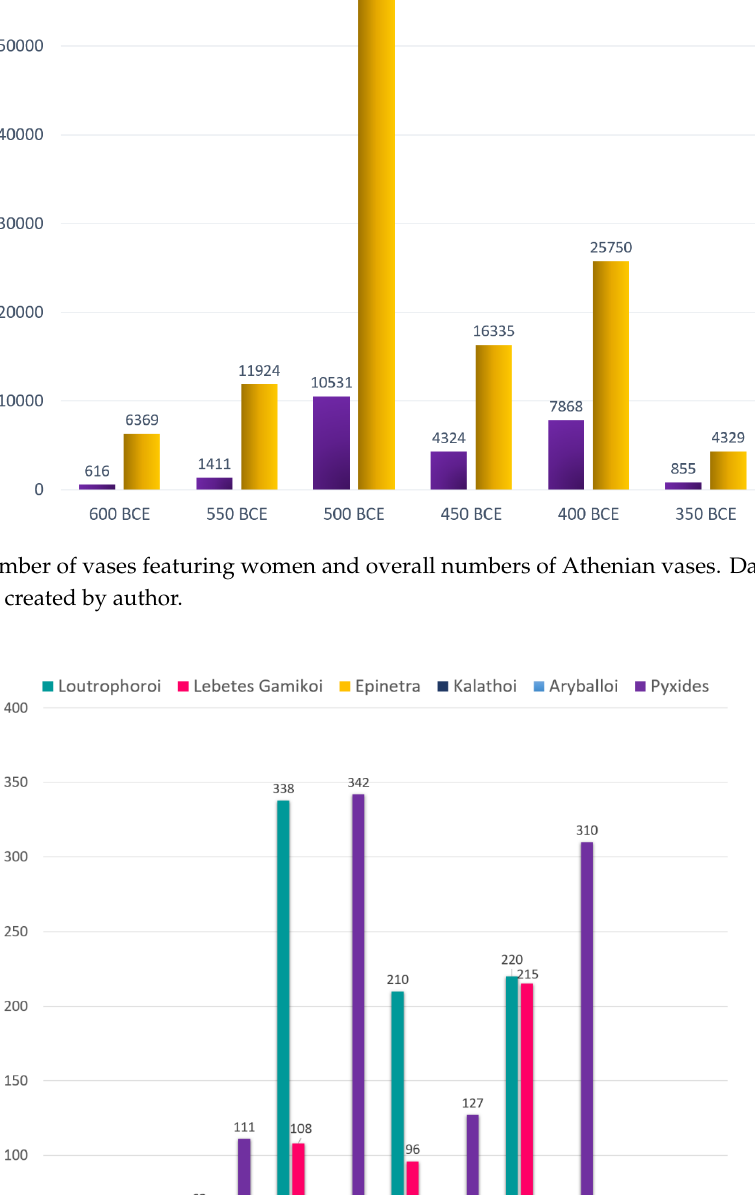
Figure 8. Relative numbers of Athenian vase-paintings featuring women in the imagery on lekythoi grouped by approximate dates. Data from the BAPD. Chart created by author. Along with the general increase in the depictions of women, women were regularly the focus of one image or a series of images on a single vase, rather than simply appearing as spectator figures as was the case in the 6th century BCE (Stansbury-O ’ Donnell 2006, pp. 187 – 229). During the 5th century